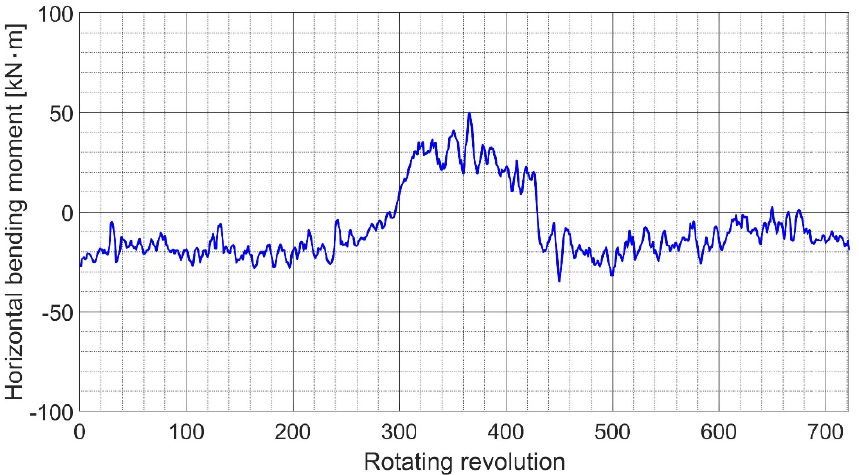
Figure 12. Bending moment in the horizontal direction during the port turn under the fully laden condition.